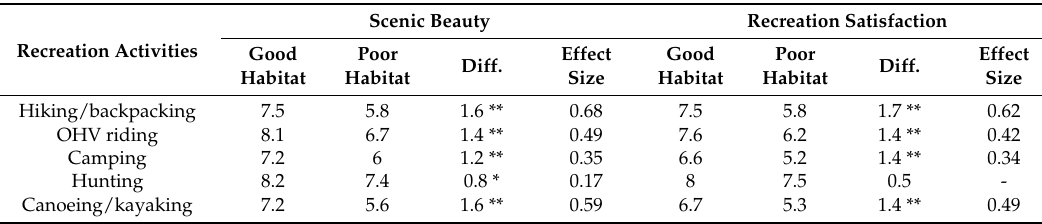
Table 2. Comparison between good and poor-quality red-cockaded woodpecker habitats in Ocala National Forest in terms of recreationists’ perceived scenic beauty and recreation satisfaction.